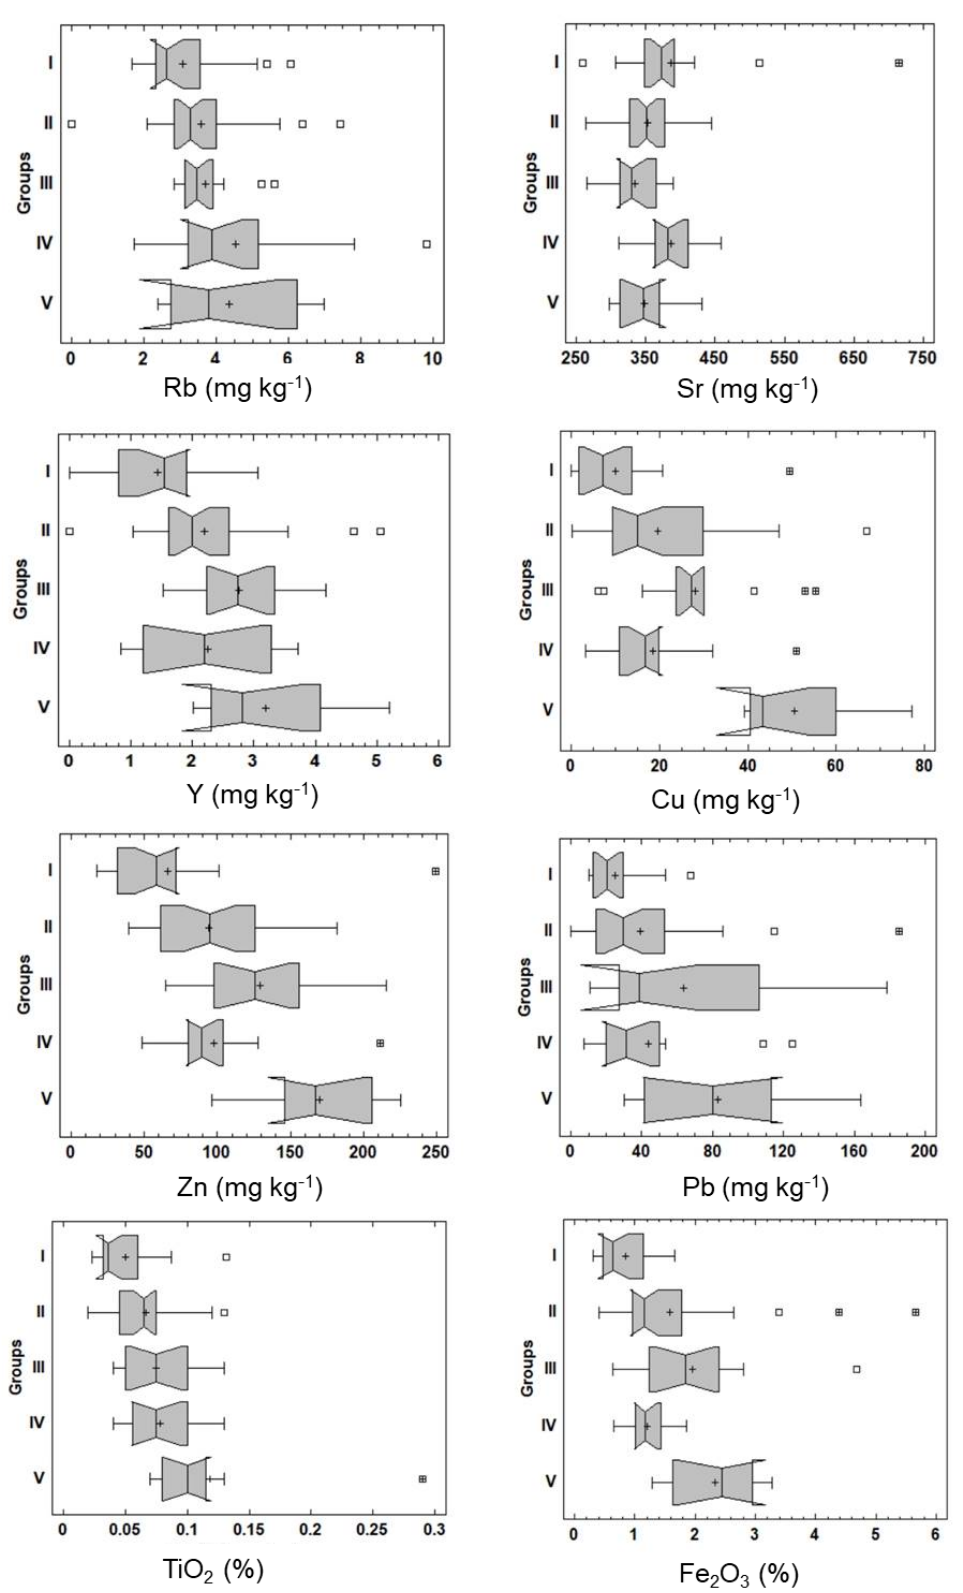
Figure 4. Comparison of medians of presumably contaminating elements and oxides by groups of road dust. I, GB, greyish brown; II, G, gray; III, DG, dark gray; IV, DGB, dark grayish brown; and V, VDG, very dark gray.